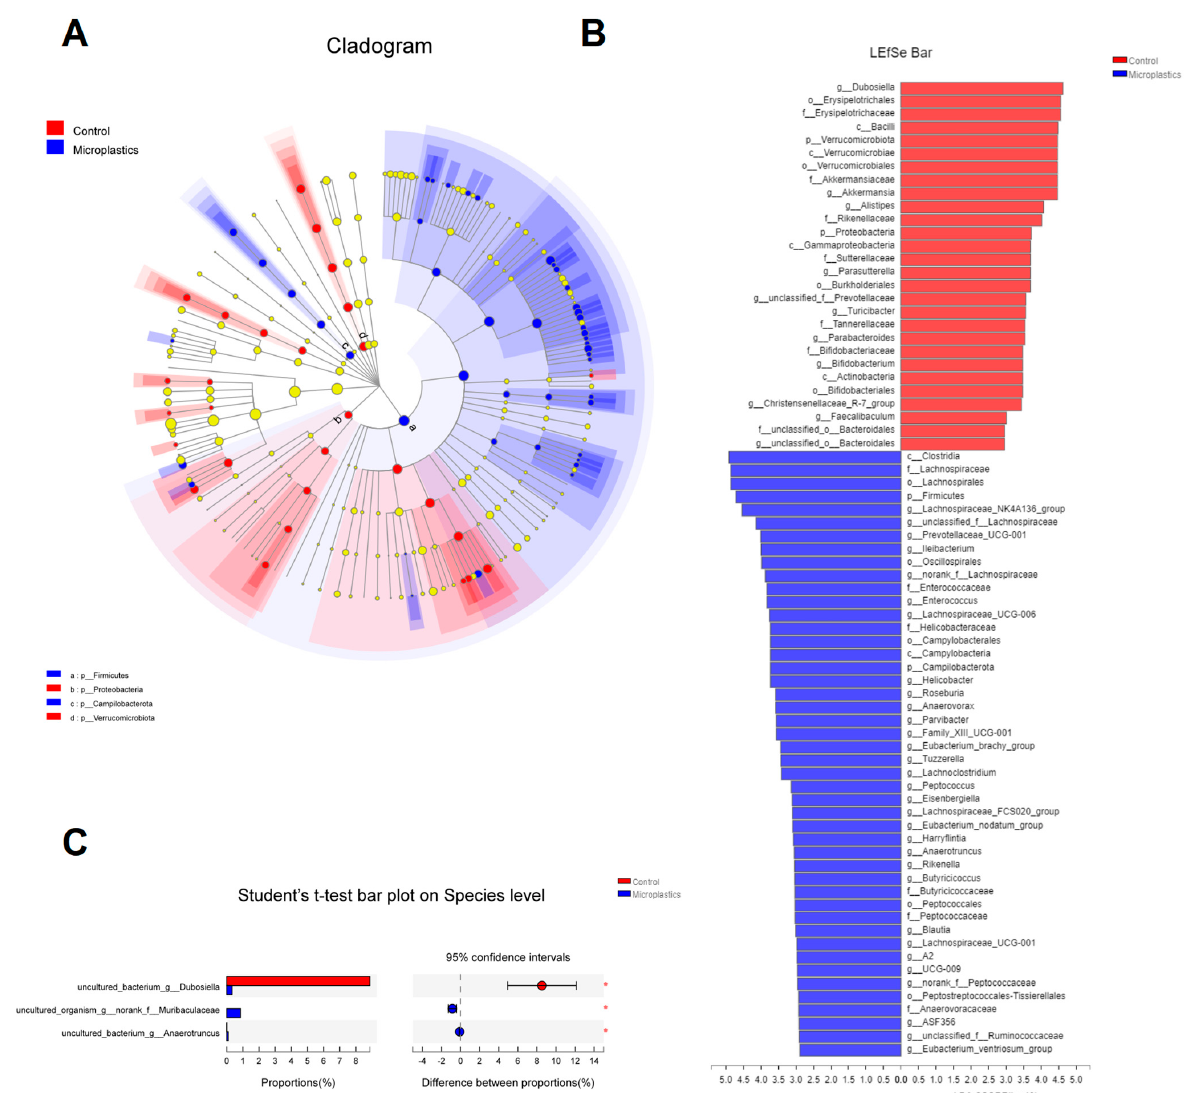
Figure 2. ( A ) Cladogram (phylum to genus) by discriminant analysis of Lefse with different colors representing control (Red) or microplastics (Blue) groups ( n = 8). ( B ) Discriminant analysis of Lefse multi-level species difference ( n = 8). ( C ) Community barplot analysis at species level ( n = 8, * p < 0.05).